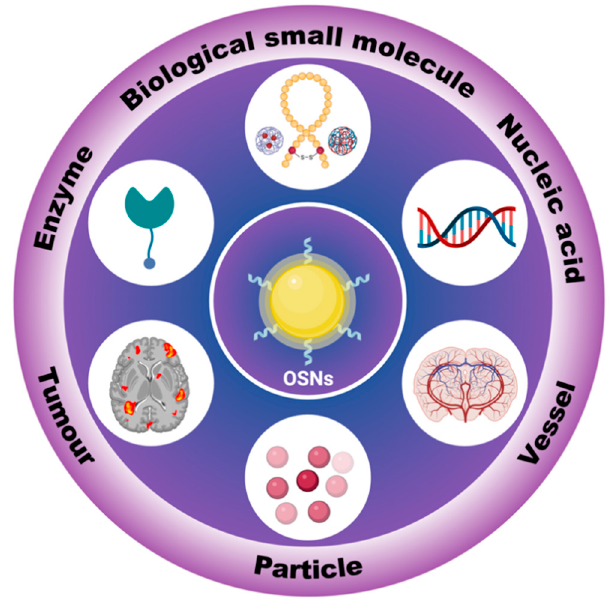
Figure 1. The application of OSNs in biosensors.